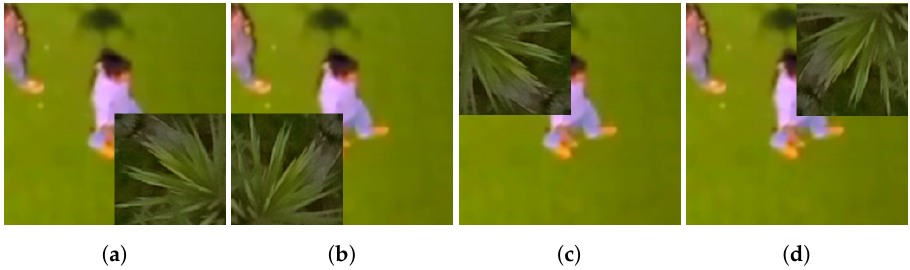
Figure 11. Samples of occlusion experiments: ( a ) occlusion on bottom-right quadrant; ( b ) occlusion on bottom-left quadrant; ( c ) occlusion on top-left quadrant; ( d ) occlusion on top-right quadrant;